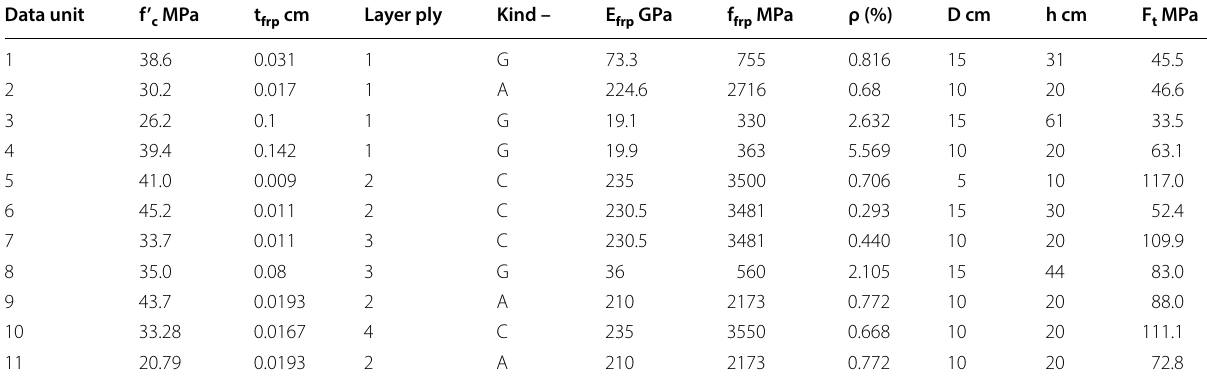
Table 2 Samples for training data set in this study (part in 284